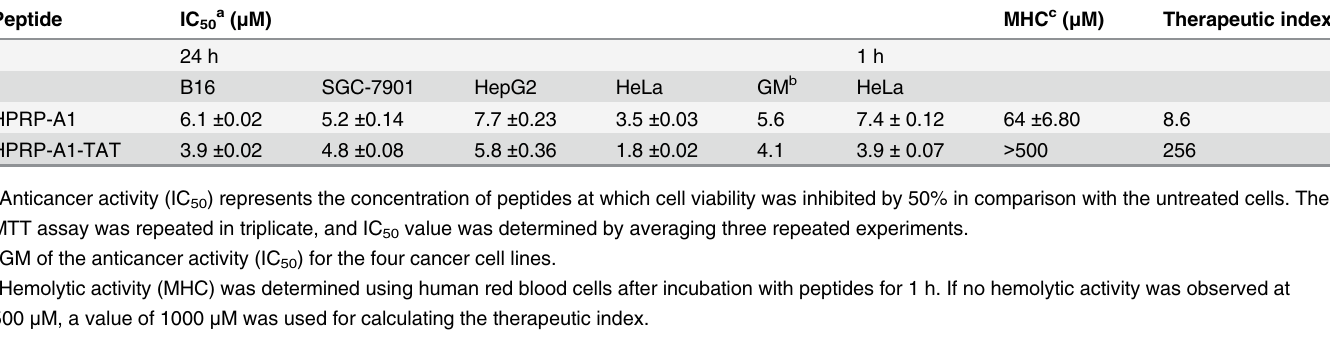
Table 2. Anticancer (IC 50 ) and hemolytic activities (MHC) of peptides against cancer cells and human red blood cells. Peptide IC 50a ( μ M)